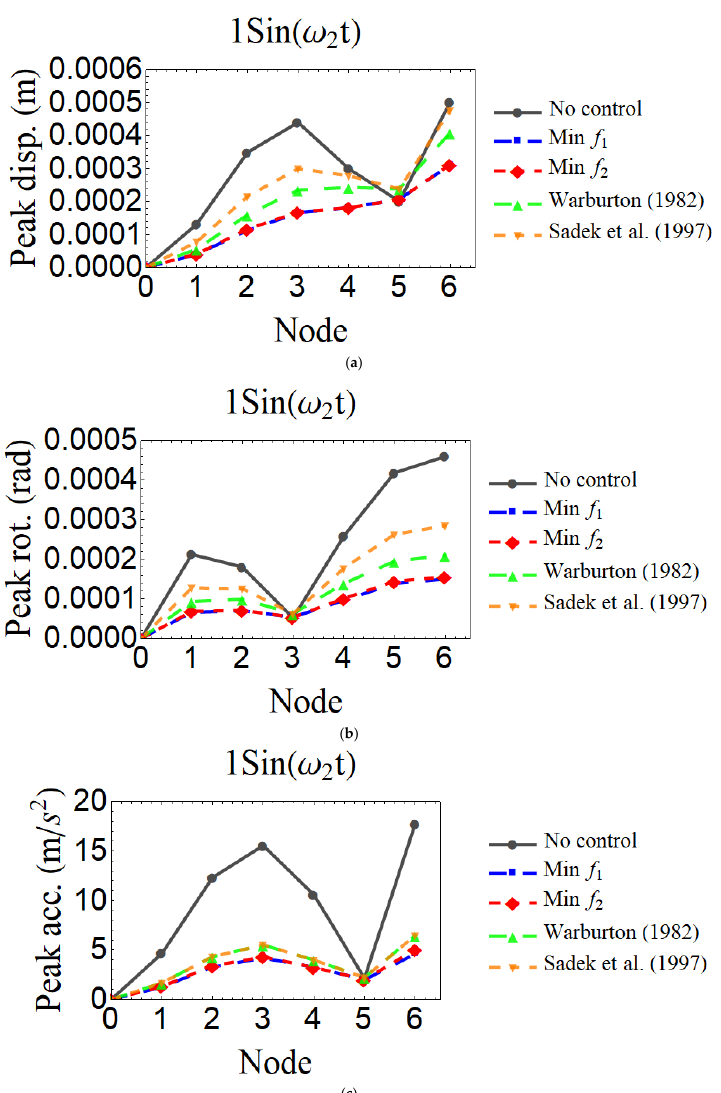
Figure 12. The peak node responses of the cantilever beam in comparison with [29], [30] for the second mode control ( a ) peak displacements, ( b ) peak rotations, and ( c ) peak accelerations.